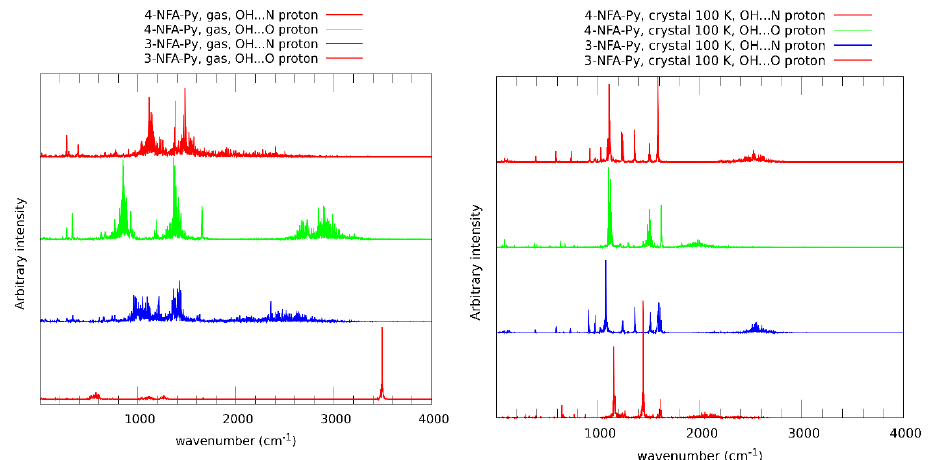
Figure A2. Calculated power spectra of atomic velocity—results of CPMD runs for the 3NFA ‐ P and 4NFA ‐ P complexes in the gas phase and in the solid state (T = 100 K). CPMD power spectra are presented only for the bridged protons vibrational modes.